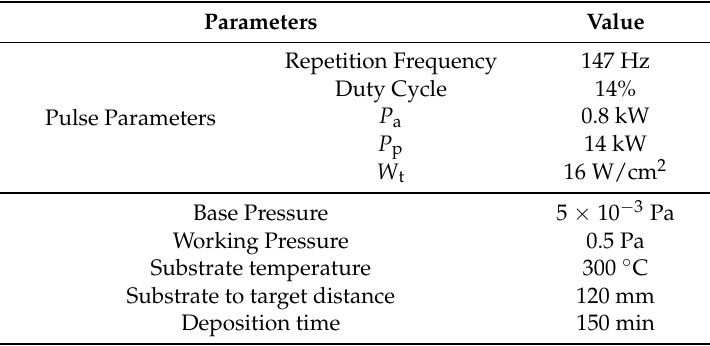
Table 1. The HiPIMS pulsing parameters and deposition conditions for NbN coatings.